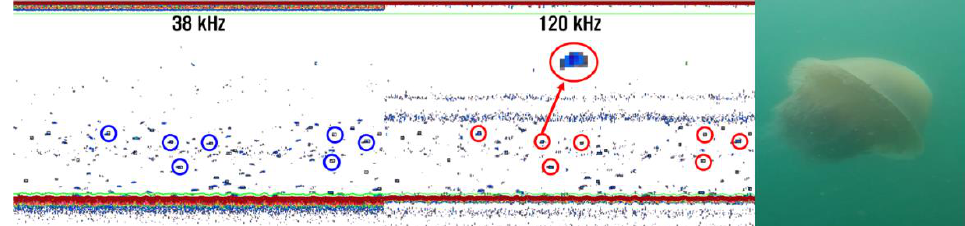
Figure 4. Echo signals of jellyfish displayed on the echogram.